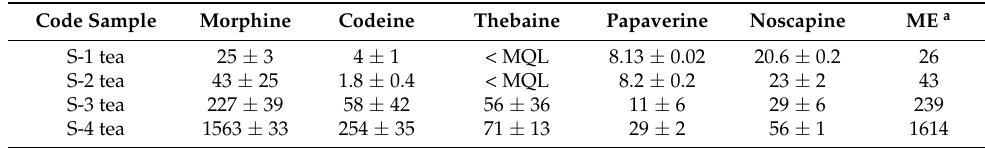
Table 3. Occurrence of opium alkaloids (main concentration ( µ g/L) of three replicates ± stan- dard deviation) in poppy seed teas prepared with four different samples of poppy seeds (S-1, S-2, S-3 and